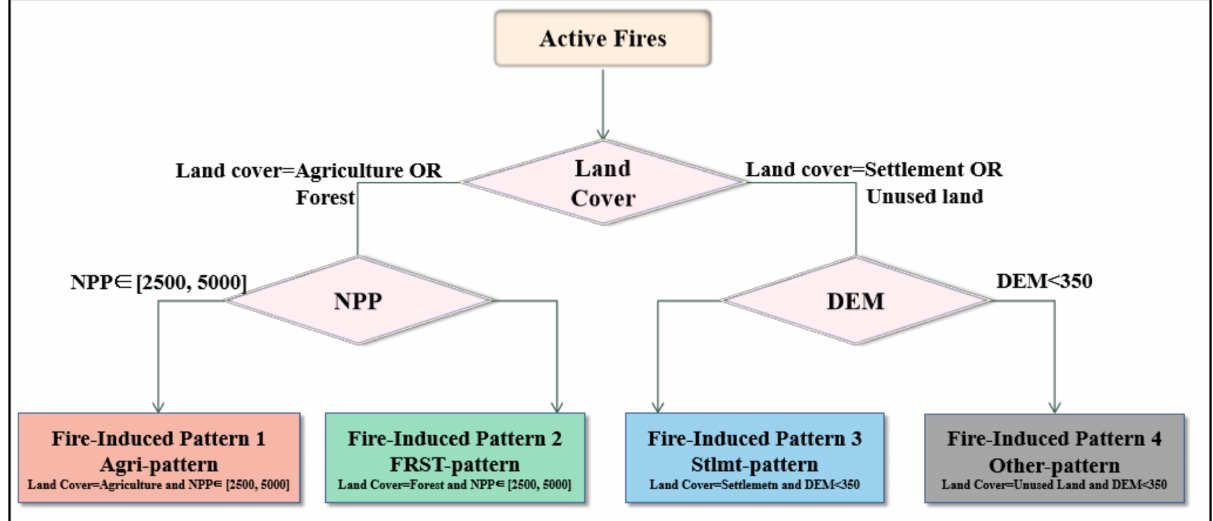
Figure 9. The decision tree based conceptual model for delineating fire-induced patterns based on VIIRS active fires in Northeast